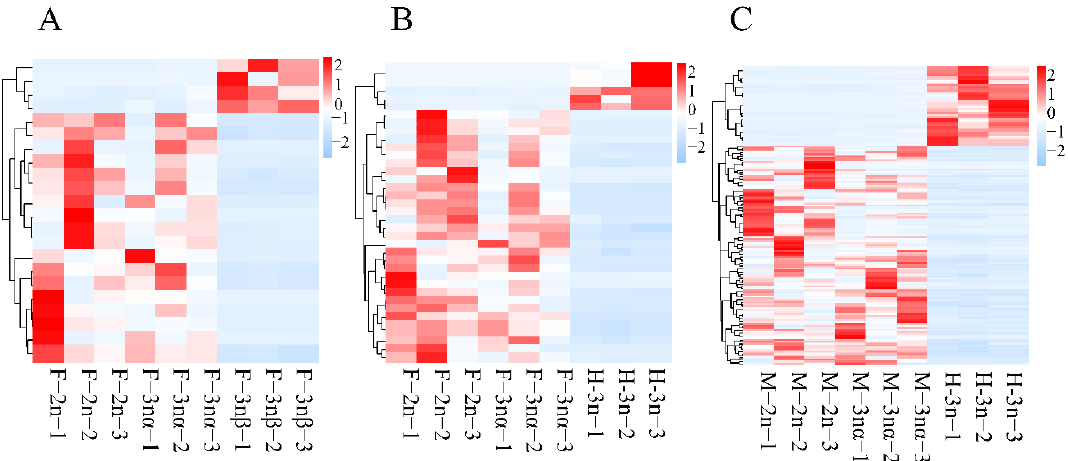
Figure 2. Transcript patterns of DELs in F-3n β group ( A ), HF-3n group ( B ), and HM-3n group ( C ) are presented in heatmaps. Red indicates relatively high expression, while blue indicates relatively low expression among samples.